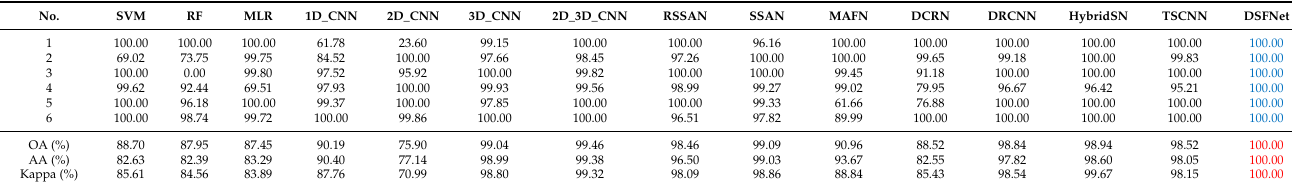
Table 5. Classification results on the SAC